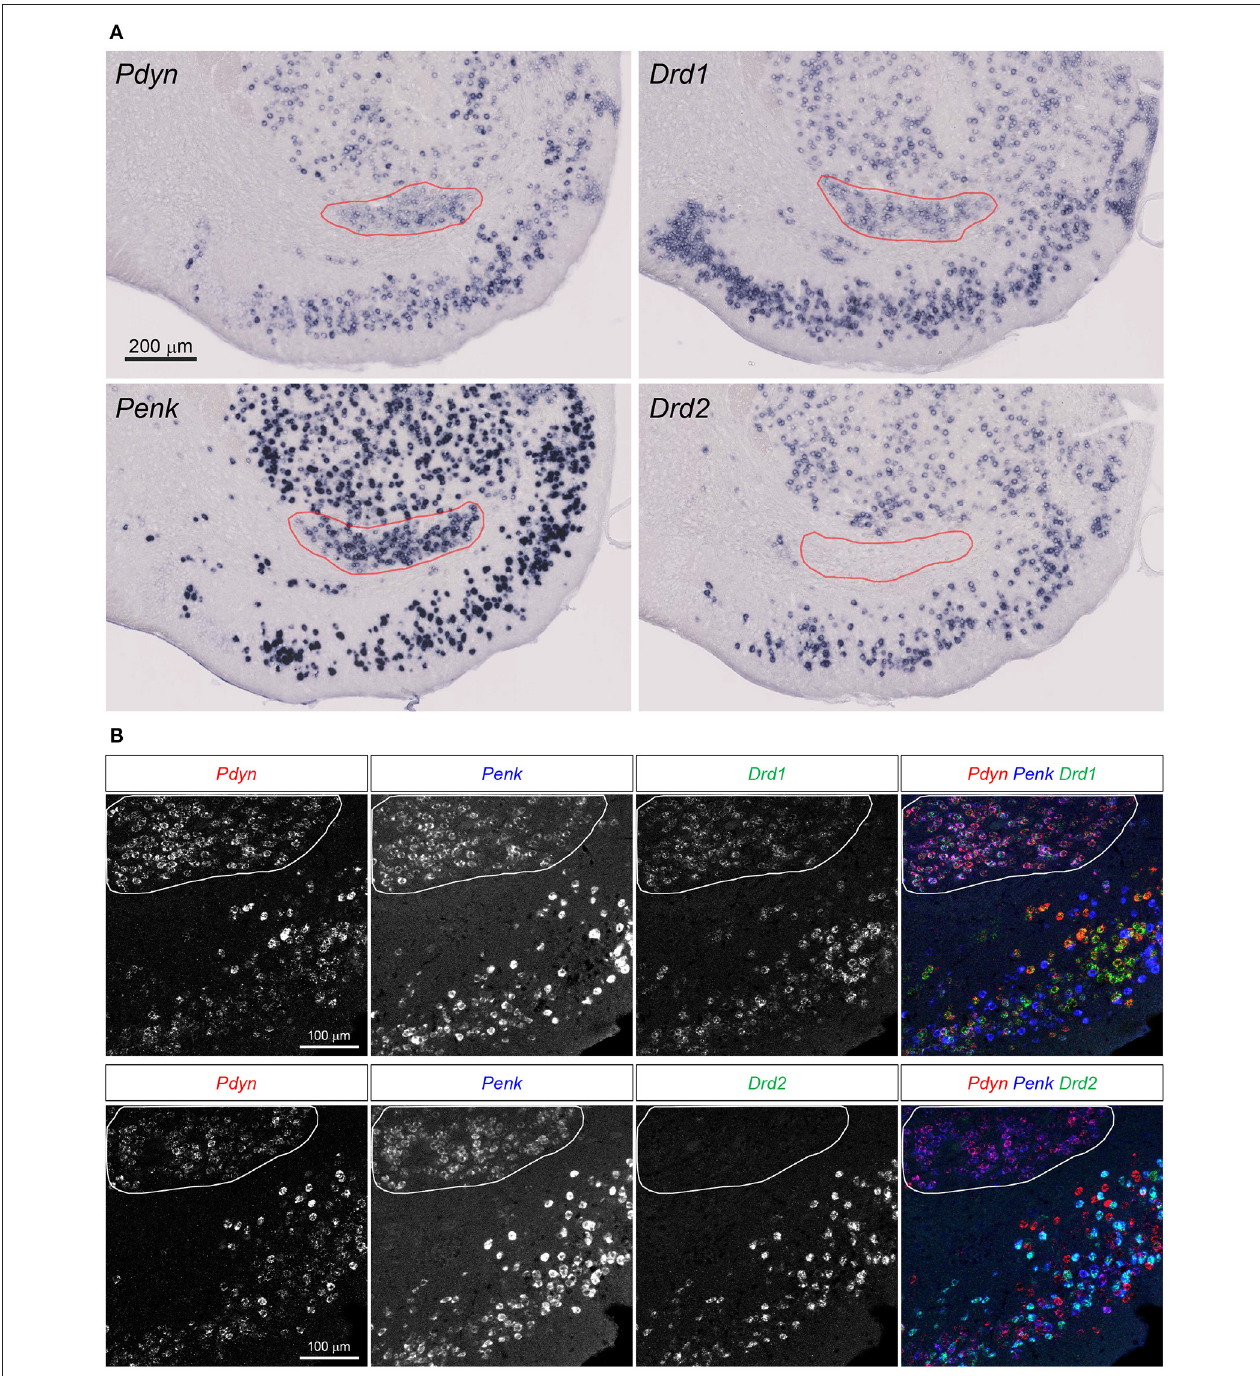
FIGURE 3 | Pdyn-Penk-Drd1 co-expressing cell cluster in the anterior ventral striatum. (A) Single probe ISH for Pdyn, Penk, Drd1, and Drd2. The pictures show coronal sections of the anterior OT and NAc (approximately at Bregma + 1.94mm). Regions delineated by red lines are a cluster of Pdyn-Penk-Drd1 co-expressing cells. Drd2 signals were not observed in the cluster. Adjacent sections from one mouse were used for the four pictures. Brain sections in this figure (A) were sampled from the same mouse used in Figure 2 . (B) Triple fluorescence ISH for Pdyn-Penk-Drd1 (Upper panels) and Pdyn-Penk-Drd2 (Lower panels). Regions delineated by white lines are a cluster of Pdyn-Penk-Drd1 co-expressing cells which did not express Drd2.